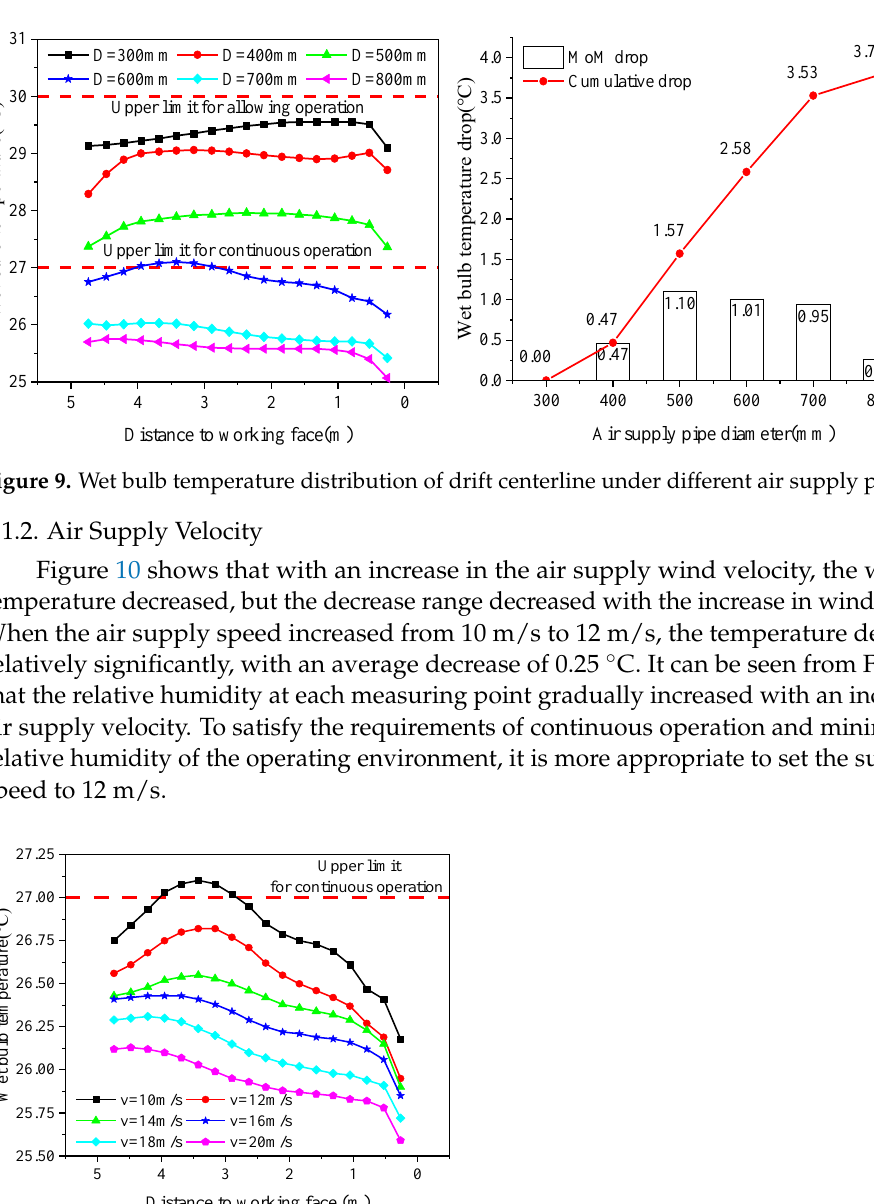
Figure 11. Relative humidity distribution of drift centerline under different air supply velocity. 5.2. Temperature of Supply Air As shown in Figure 12, with an increase in the supply air temperature, the tempera- ture of the measuring point on the centerline of the drift increased. For every 2 °C decrease in air supply temperature, the temperature drop of each point on the drift centerline was basically the same, and the wet bulb temperature dropped by 0.9 °C on average, which shows that reducing air supply temperature has a significant equal proportion cooling effect on reducing the airflow temperature of working face. In addition, the closer the measuring point was to the working face, the lower the temperature. From the distribution of relative humidity in Figure 13, with a decrease in air supply temperature, the relative humidity of the airflow at each point on the centerline of the drift increased correspondingly, and the distance between each curve gradually increased with a decrease in the supply air temperature. This is because the saturated partial pressure of water vapor decreases with a decrease in the air flow dry-bulb temperature, and the two